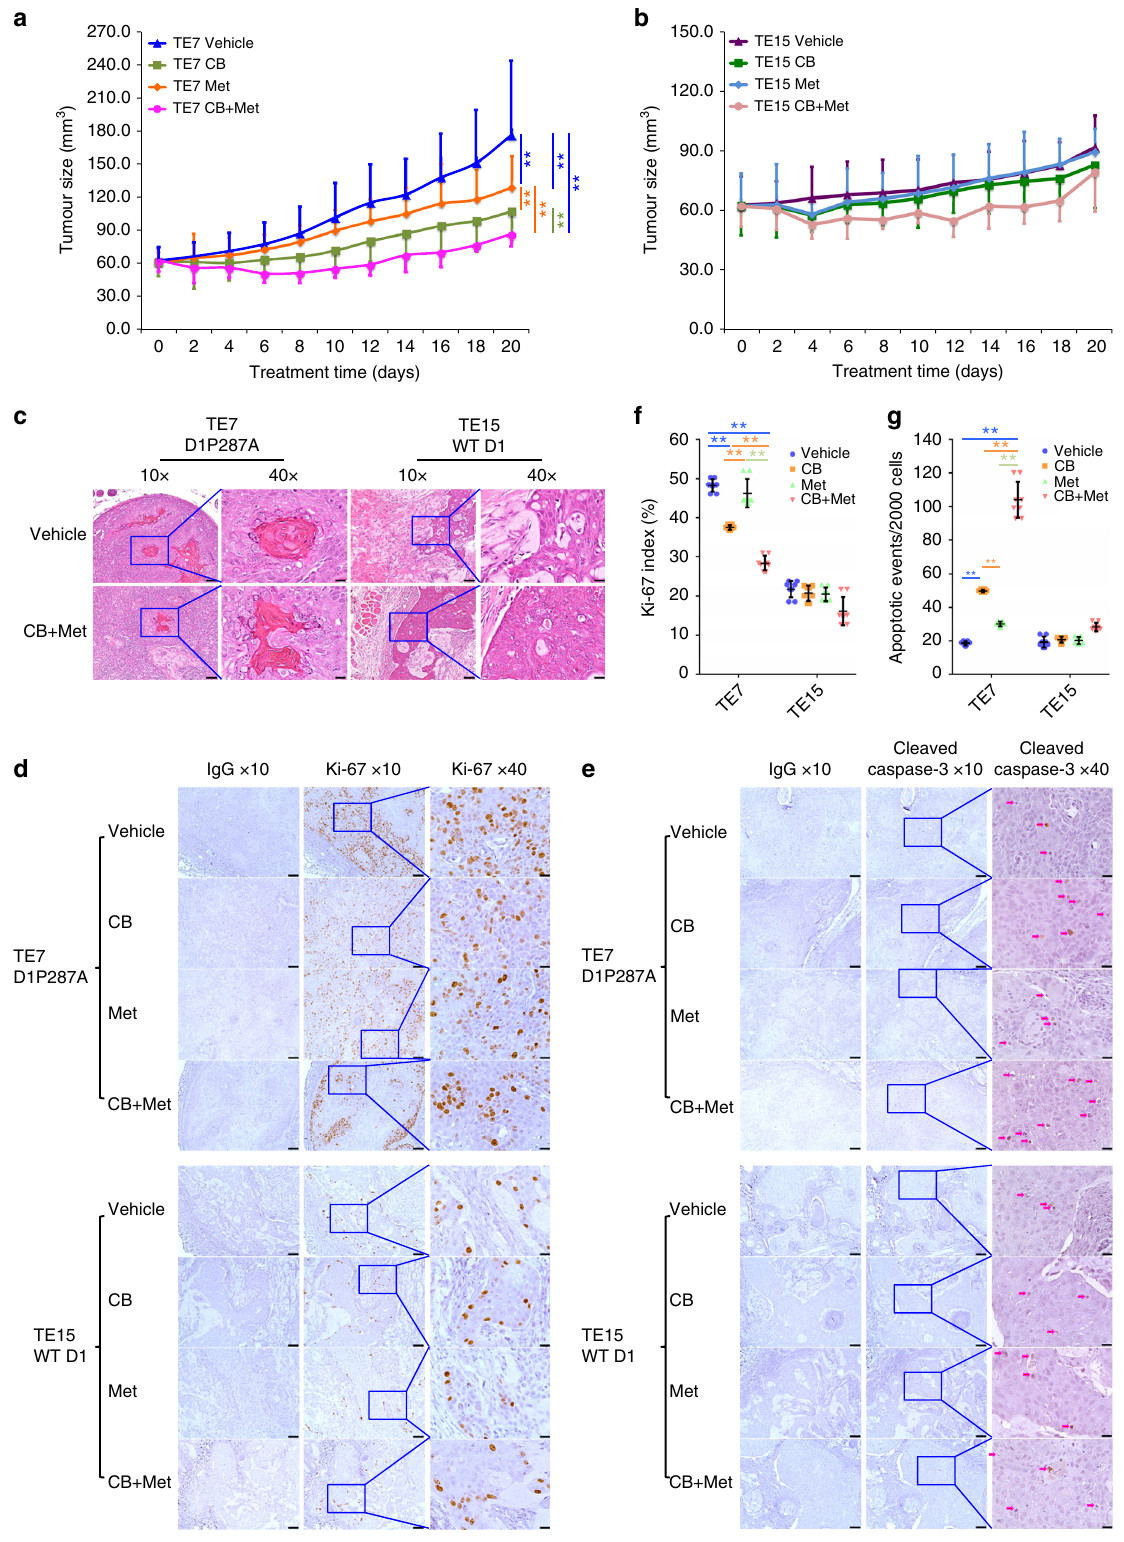
Fig. 6 Combined treatment inhibits xenograft growth and induces apoptosis in vivo. a , b Growth curve of TE7 ( a ) and TE15 ( b ) xenografts. Data represent as mean ± s.d., two-way ANOVA was used to compare means with Bonferroni as Post Hoc test ( n = 8). ** p < 0.01. c H&E staining sections from TE7 and TE15 xenografts. d IHC staining of Ki-67 in xenograft tissues. e IHC staining of cleaved caspase-3 in xenograft tissues, magenta arrow indicates positive cells. f Comparison of Ki-67 index among different groups. g Quanti fi cation of cleaved caspase-3 positive cells per 2000 cells. All data in f and g represent as mean ± s.d., one-way ANOVA was used to compare means with Bonferroni as Post Hoc test ( n = 8). ** p < 0.01. Scale bar, 10 μ